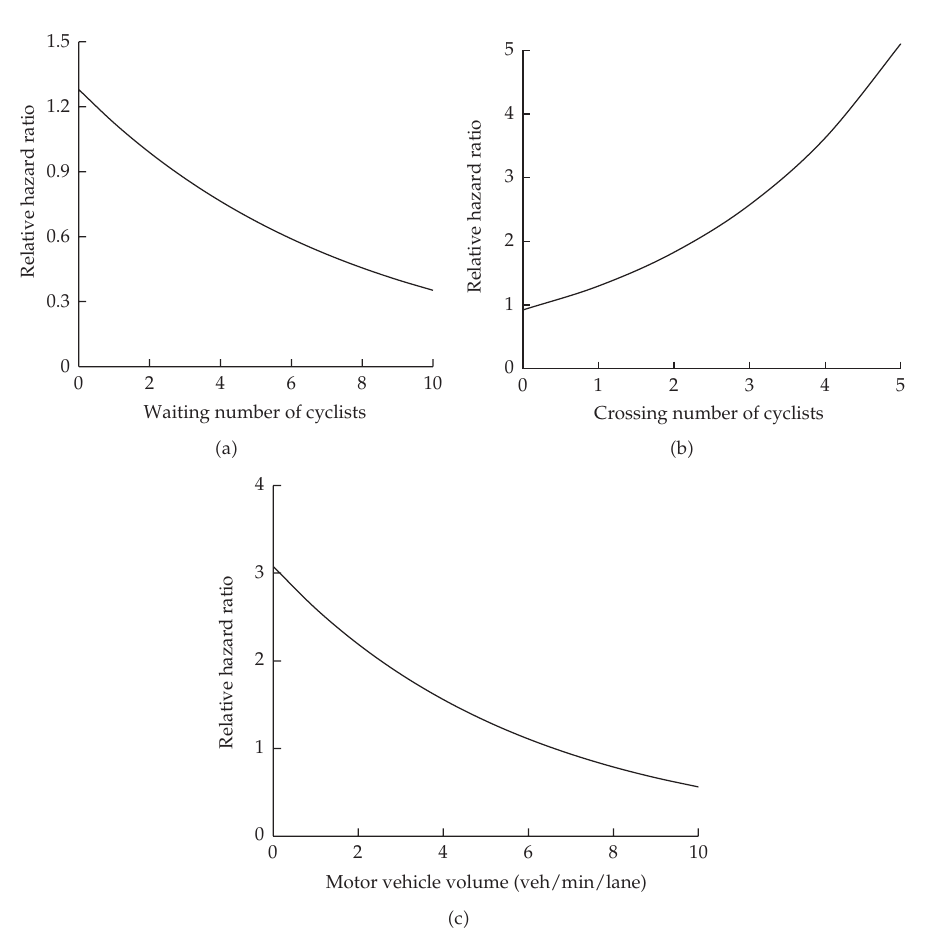
Figure 2: Relative hazard ratios for three continuous